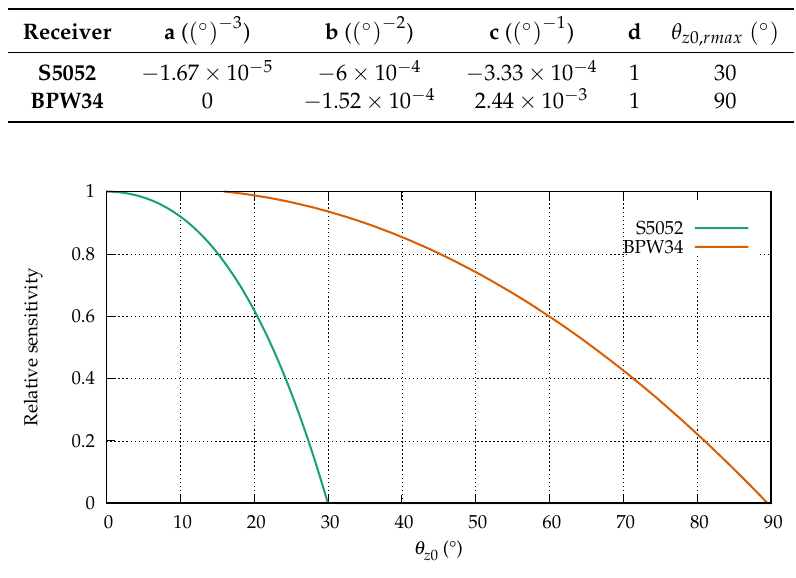
Figure 9. Angular receiver